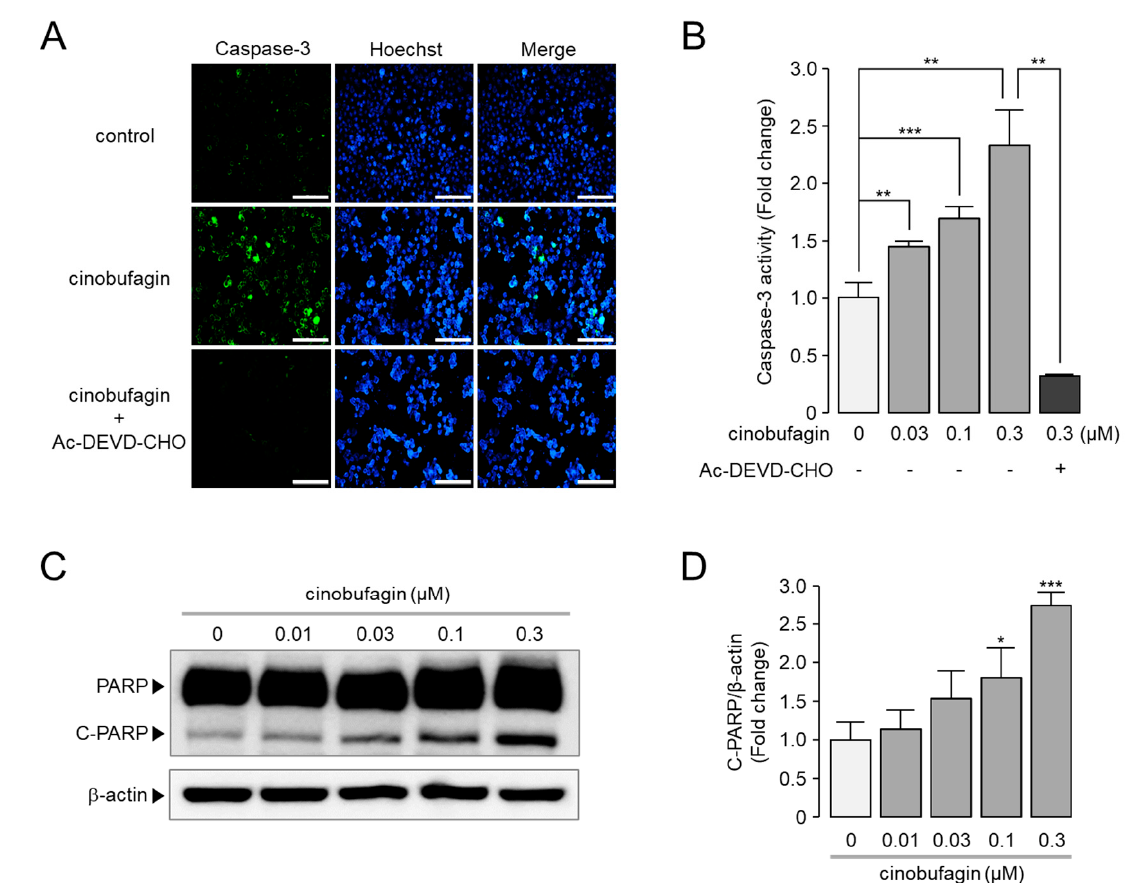
Figure 6. Effect of cinobufagin on caspase-3 activation and induction of PARP cleavage in CAL-27 cells. ( A ) Images were taken 24 h after application of 300 nM cinobufagin. Cells were incubated with caspase-3 substrate (green) and Hoechst 33342 (blue) 20 min prior to image acquisition. Scale bars represent 200 µ m. ( B ) CAL-27 cells were treated with the indicated concentrations of cinobufagin in the presence or absence of 10 µ M of Ac-DEVD-CHO for 24 h, then the cells were treated with 2 μ M of caspase-3 substrate for 20 min to estimate caspase-3 activity (mean ± S.E., n = 3). ( C ) Representative immunoblot analysis of PARP and cleaved PARP(C-PARP). Cells were treated with the indicated concentrations of cinobufagin for 24 h. ( D ) Cleaved PARP protein intensities were normalized to those of β -actin (mean ± S.D., n = 3). * p < 0.05, ** p < 0.01, *** p < 0.001.